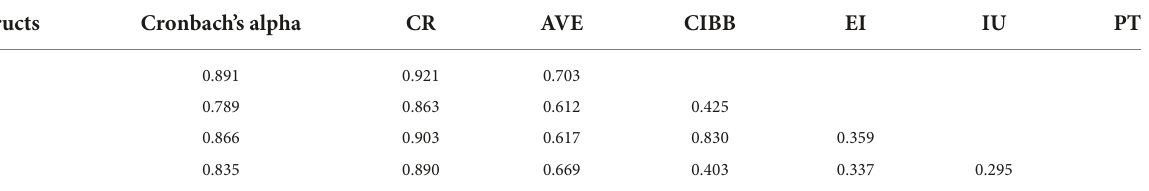
TABLE 2 Measurement model and HTMT.